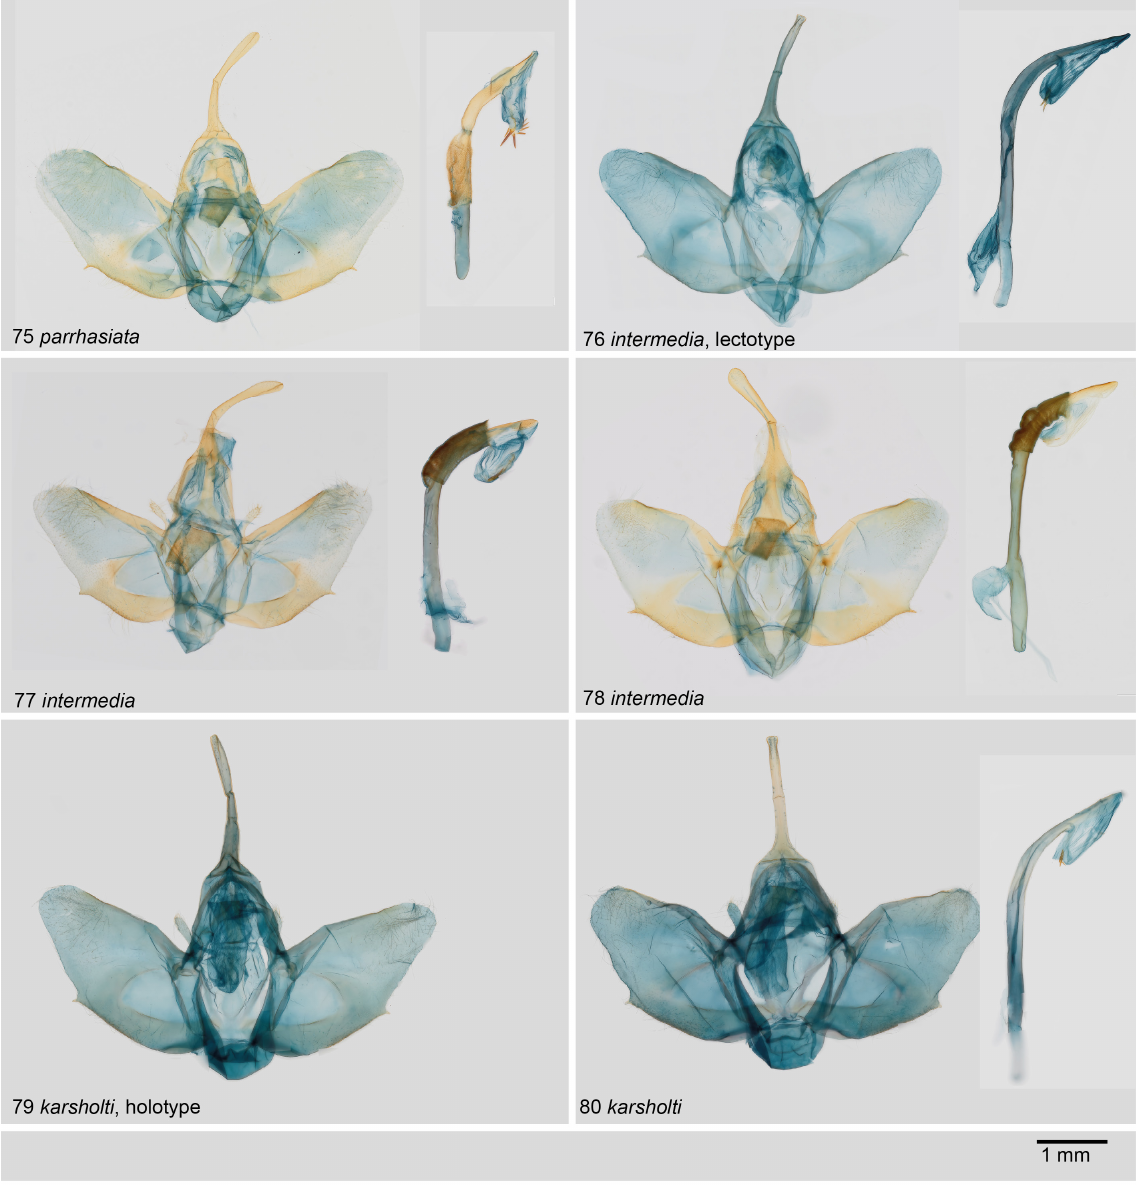
Figs 75–80. Male genitalia (left = valves; right = aedeagus). 75 . Callipia parrhasiata Guenée, 1858, ♂ (C-0039, COI data). 76 . C. intermedia Dognin, 1914 stat. rev., ♂, lectotype (C-0327). 77 . C. intermedia Dognin, 1914 stat. rev., ♂ (C-0031, COI data). 78 . C. intermedia Dognin, 1914 stat. rev., ♂ (C-0097). 79 . C. karsholti sp. nov., ♂, holotype (C-0033, COI data). 80 . C. karsholti sp. nov., ♂ (C-0349, COI